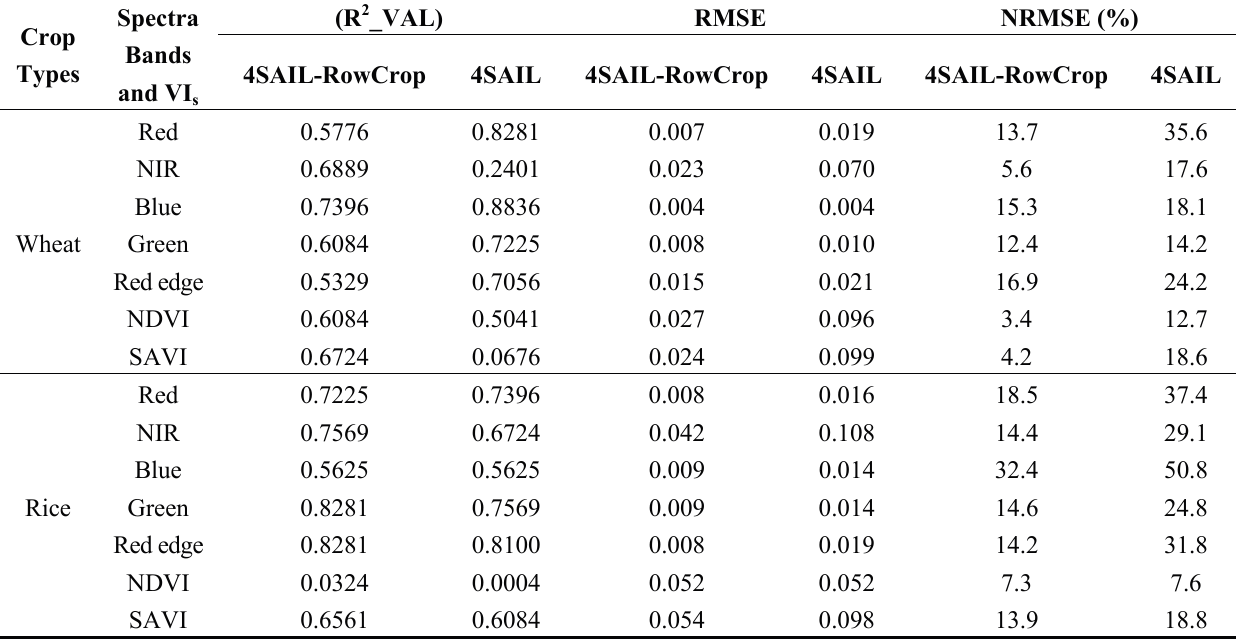
Table 10. Correlation of the simulated bidirectional reflectance spectra determined using the 4SAIL-RowCrop and 4SAIL model with field